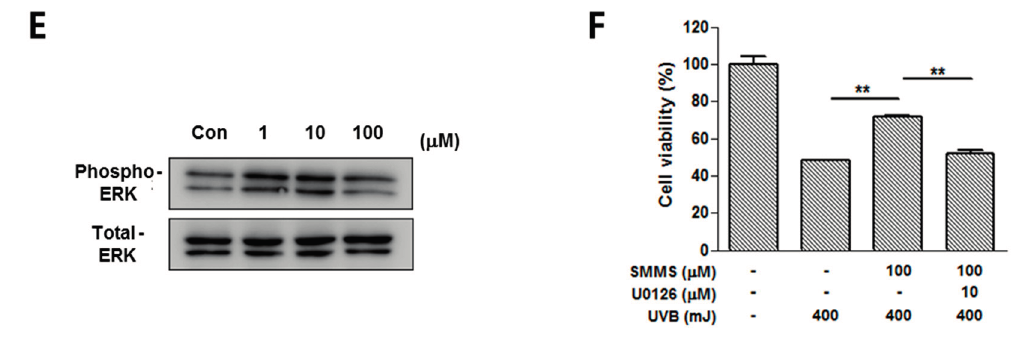
Figure 1. Photoprotective effect of S -methylmethionine sulfonium (SMMS) in keratinocyte progenitor cells (KPCs). ( A ) Cell viability of KPCs was measured in the presence of 400 mJ ultraviolet B (UVB) using the MTT (3-(4,5-dimethylthiazol-2-yl)-2,5- diphenyltetrazolium bromide) assay, and SMMS significantly increased the KPC viability from UVB irradiation. Con stands for unirradiated control, (-) stands for UVB-irradiated control, n = 3; ( B ) In a fluorescence staining of propidium iodide (PI), treatment of KPCs with 100 μ M of SMMS reduced the PI-stained KPCs compared to UVB-irradiated control ( n = 1). Scale bars = 100 μ M; ( C ) SMMS treatment (1 and 10 μ M) reduced the UVB-induced reactive oxygen species (ROS) generation in KPCs ( n = 1). Scale bars = 100 μ M; ( D ) Protein levels of p53 were detected using Western blotting, and SMMS reduced UVB-induced p53 level. (-) stands for UVB-irradiated control; ( E ) SMMS increased the levels of phosphorylated extracellular receptor kinase 1/2 (ERK1/2); ( F ) Pharmacological inhibition of ERK1/2 (U0126) significantly inhibited the SMMS-induced survival of KPCs ( n = 3). * p < 0.05, ** p <